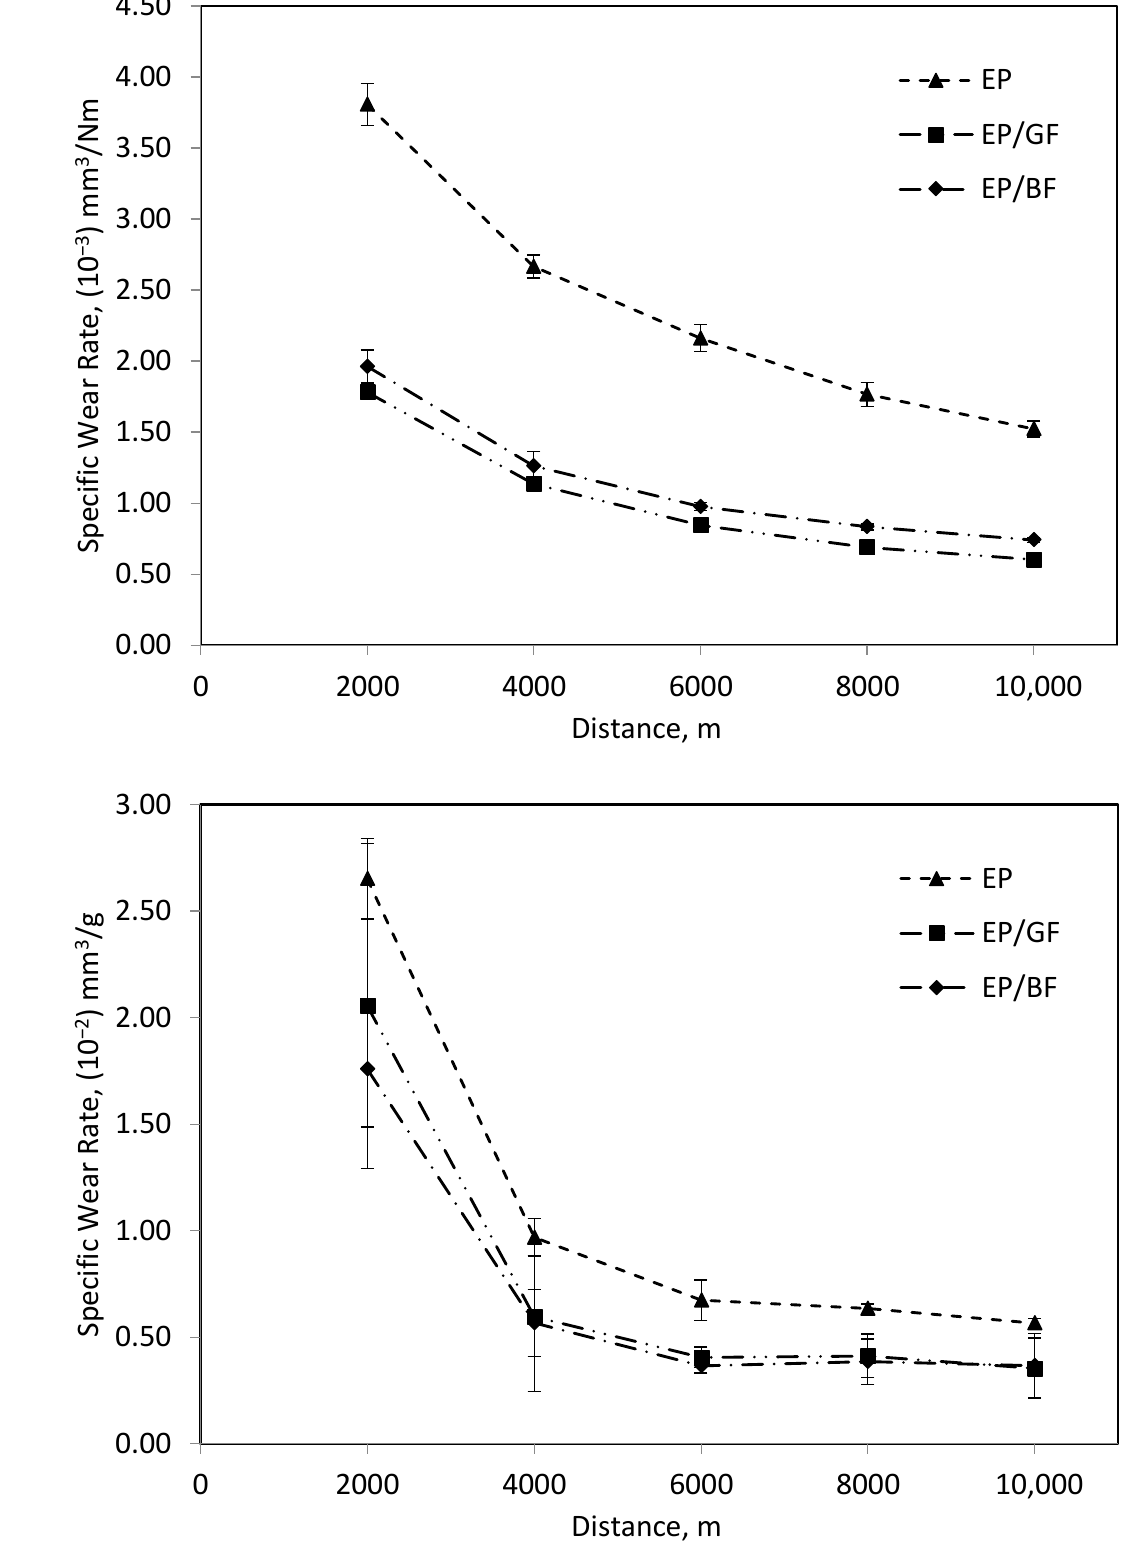
Figure 2. Typical curve of specific wear rate of pure epoxy and its composites under ( a ) adhesive, ( b ) abrasive and ( c ) erosive wear condition.